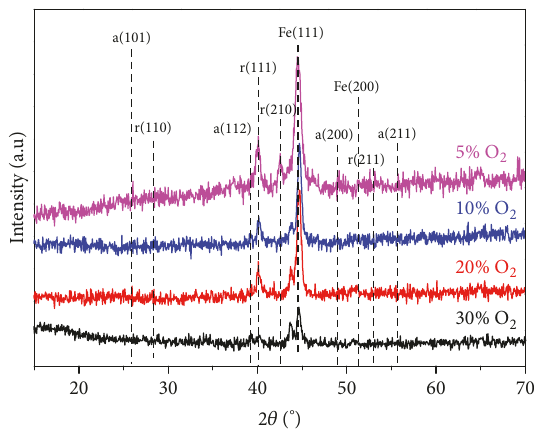
Figure 1: XRD diffraction patterns of TiO 2 films obtained for different oxygen flow rate (a: anatase, r: rutile, and Fe: